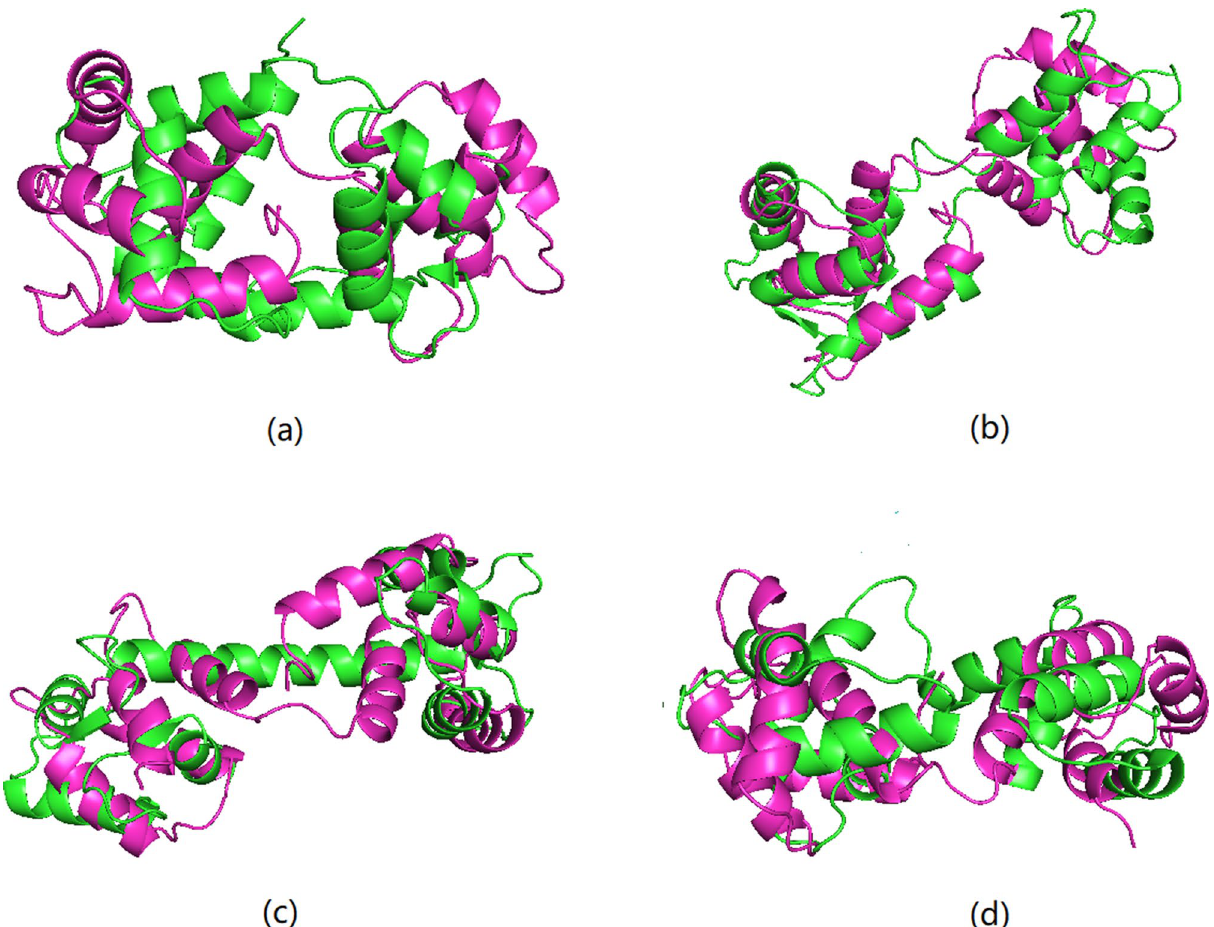
Figure 3. Alignment of empirically determined and predicted structures corresponding to a single amino acid sequence using RaptorX method. Known structures are shown in green, and predicted structure in purple,